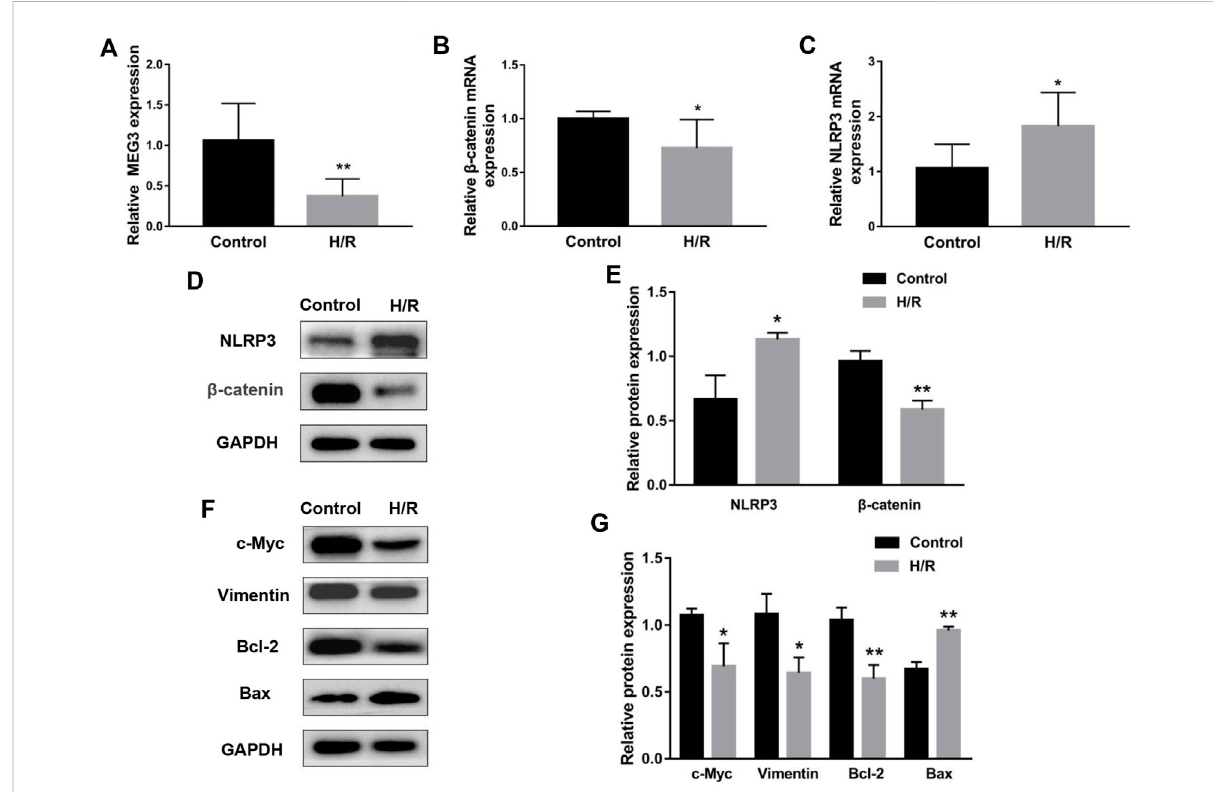
FIGURE 2 H/R treatment affected the expression of MEG3, β -Catenin and NLRP3 in trophoblast cells. H/R-induced changes in MEG3 (A) , β -Catenin (B) and NLRP3 (C) mRNA levels were assessed by qRT ‒ PCR ( n = 7/group). (D,E) H/R-induced changes in β -Catenin and NLRP3 protein levels were detected by Western blot ( n = 3/group). (F,G) The expression levels of c-Myc, Vimentin, Bcl-2, and Bax induced by H/R were detected by Western blotting ( n = 3/group). GAPDH was used as an endogenous control. * p < 0.05; ** p <